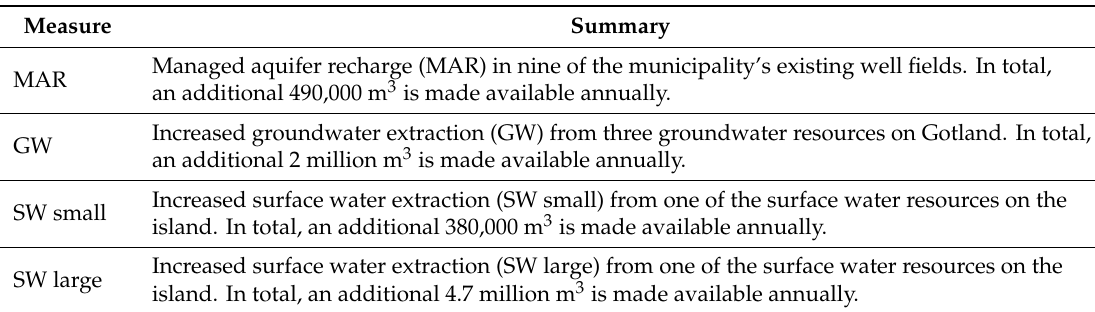
Table 2. Alternative risk reduction